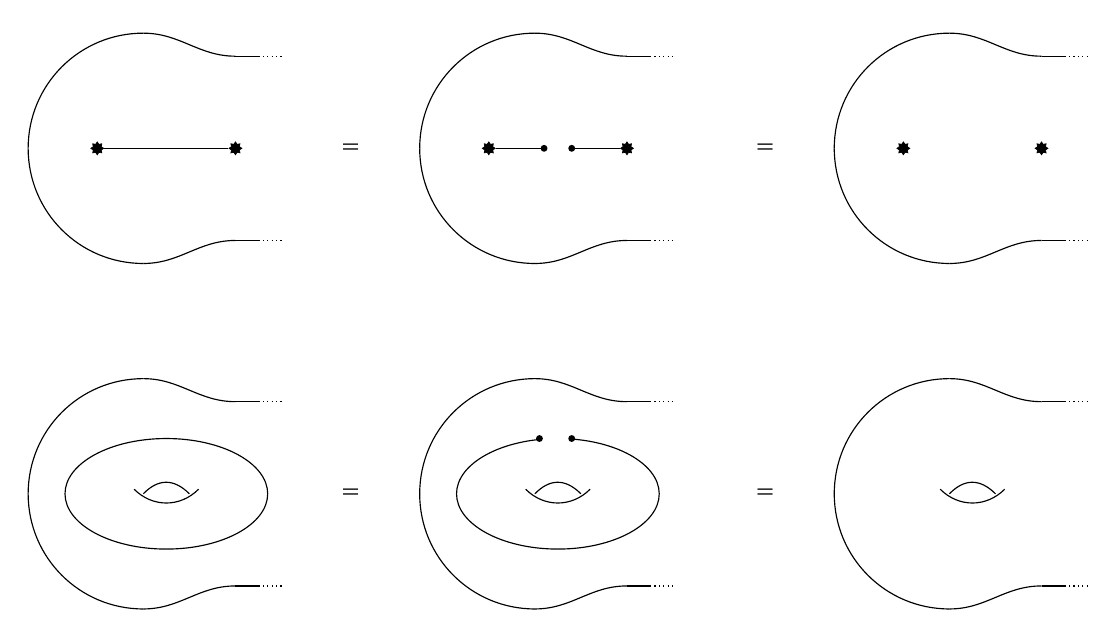
Figure 16: The figure shows various configurations of M2 branes wrapping 1-chains inside M5 branes. An M5 branes is depicted as a surface, which shows a local region of Σ . In the top-left configuration, we consider an M2 brane stretched between two r punctures on Σ . The subsequent configurations depict that we can get rid of this M2 r brane by splitting it into two by creating its end-points (shown with a black dot) on the M5 brane. Similarly, in the bottom-left configuration, we consider an M2 brane wrapping a compact 1-cycle on Σ . As shown in the subsequent configurations, we r can get rid of this M2 brane again by creating its end-points on the M5